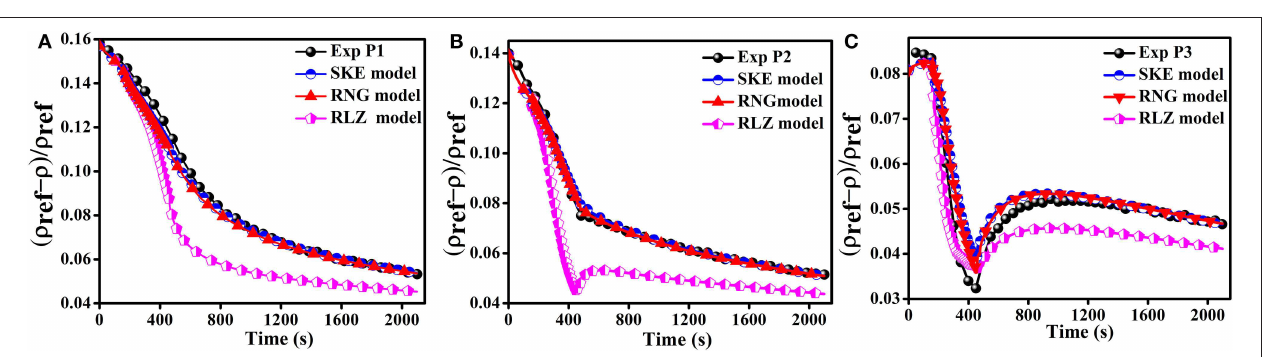
FIGURE 5 | Effect of air-injection velocity 2.83 m/s on the simulation results for monitors (A) P1, (B) P2 and (C) P3.